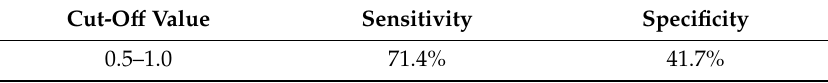
Figure 1. The receiver operating characteristics (ROC) curve of the simple model. This shows the discriminatory accuracy of the model. A value of 1 indicates perfect discrimination while 0.5 is by chance going to discriminate which woman will or will not have breast cancer. The red diagonal line represents the reference point. The blue line is the ROC curve of the simple model. Table 2. Sensitivity and specificity of the simple model on external